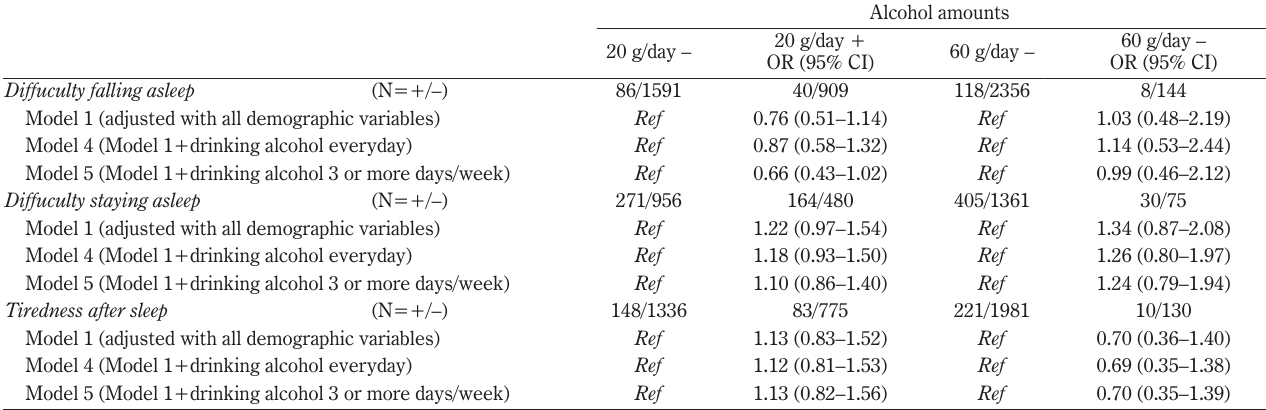
Table 3 Longitudinal association between persistent amount of alcohol consumed and insomnia